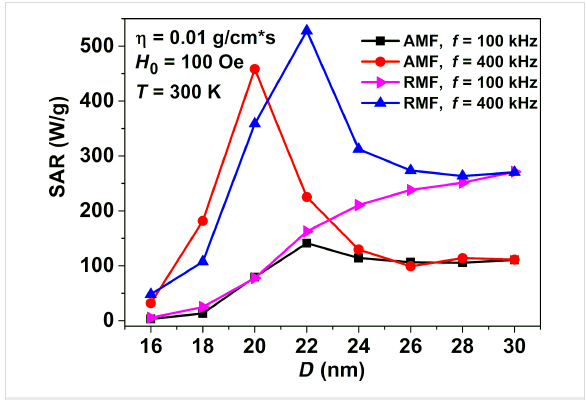
Figure 4: Comparison of the SAR of a dilute assembly of superpara- magnetic nanoparticles in AMFs and RMFs depending on the nanopar- ticle diameter for two frequencies, f = 100 and 400 kHz, at a fixed mag- netic field amplitude, H 0 = 100 Oe.